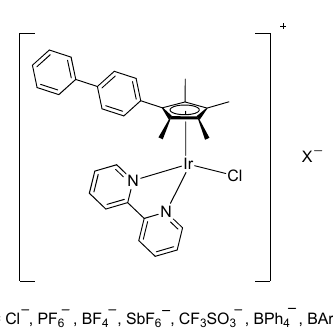
Figure 3. Varying the counteranionsin organometallic half-sandwich iridium(III) compounds.